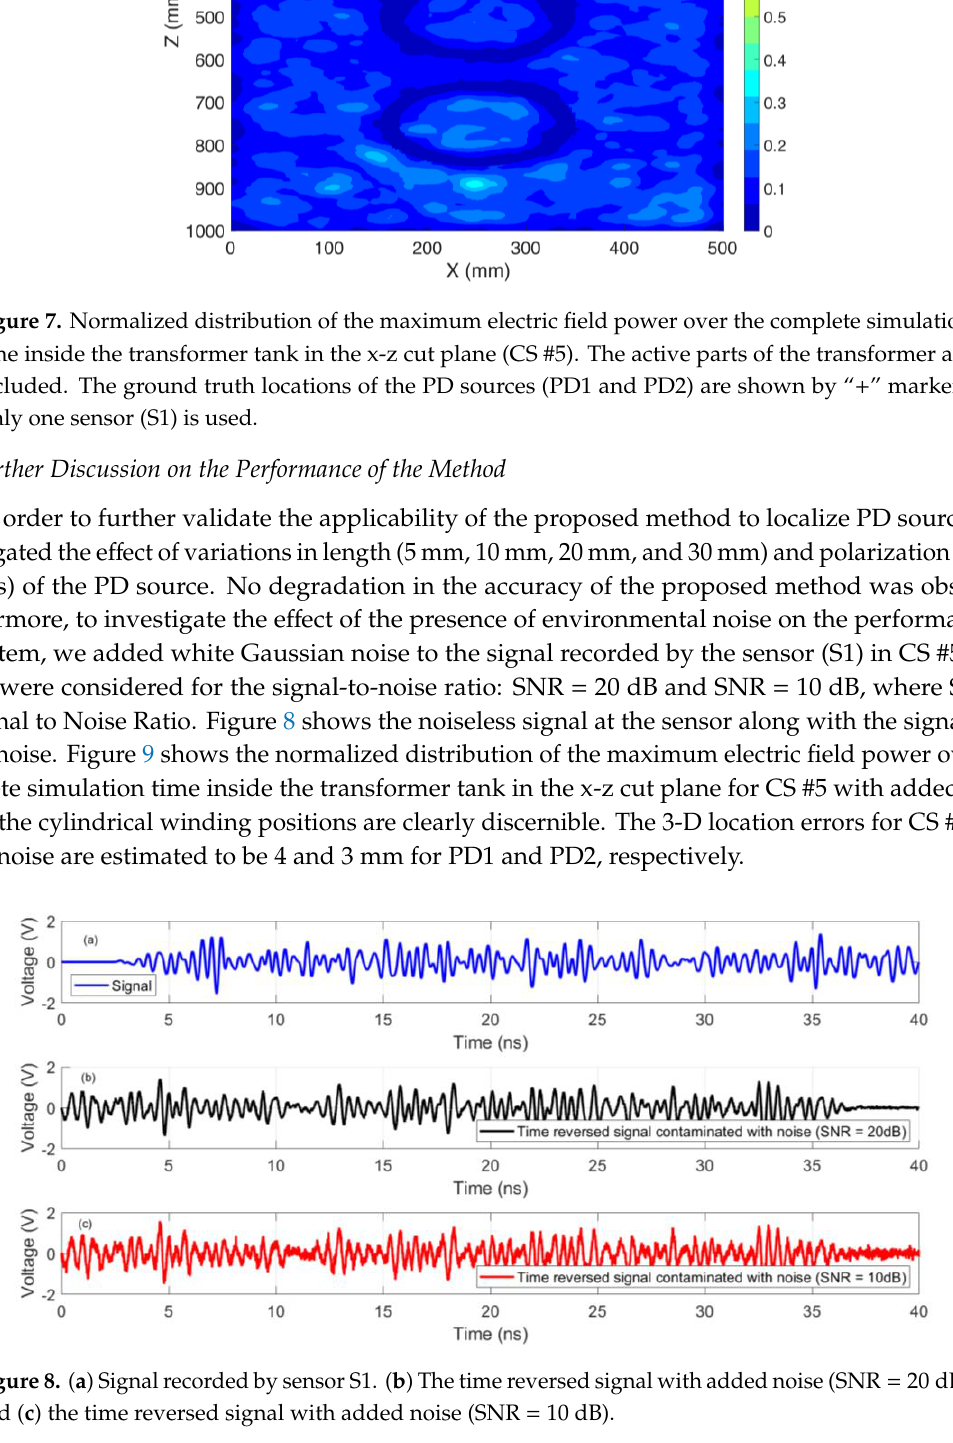
Figure 8. ( a ) Signal recorded by sensor S1. ( b ) The time reversed signal with added noise (SNR = 20 dB), and ( c ) the time reversed signal with added noise (SNR = 10